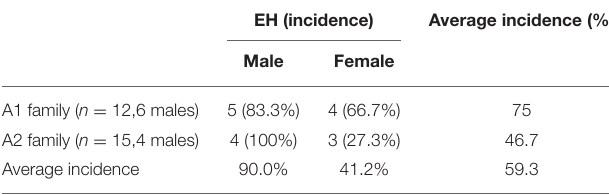
TABLE 3 | Onset age of EH and blood pressure of tRNA 15910 C > T patients with EH and patients with non-maternally inherited